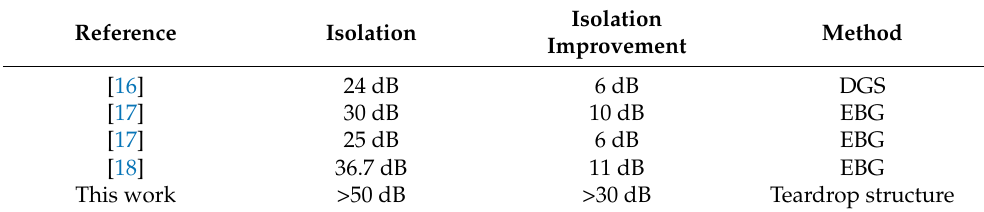
Table 2. Comparison of isolation optimization of different